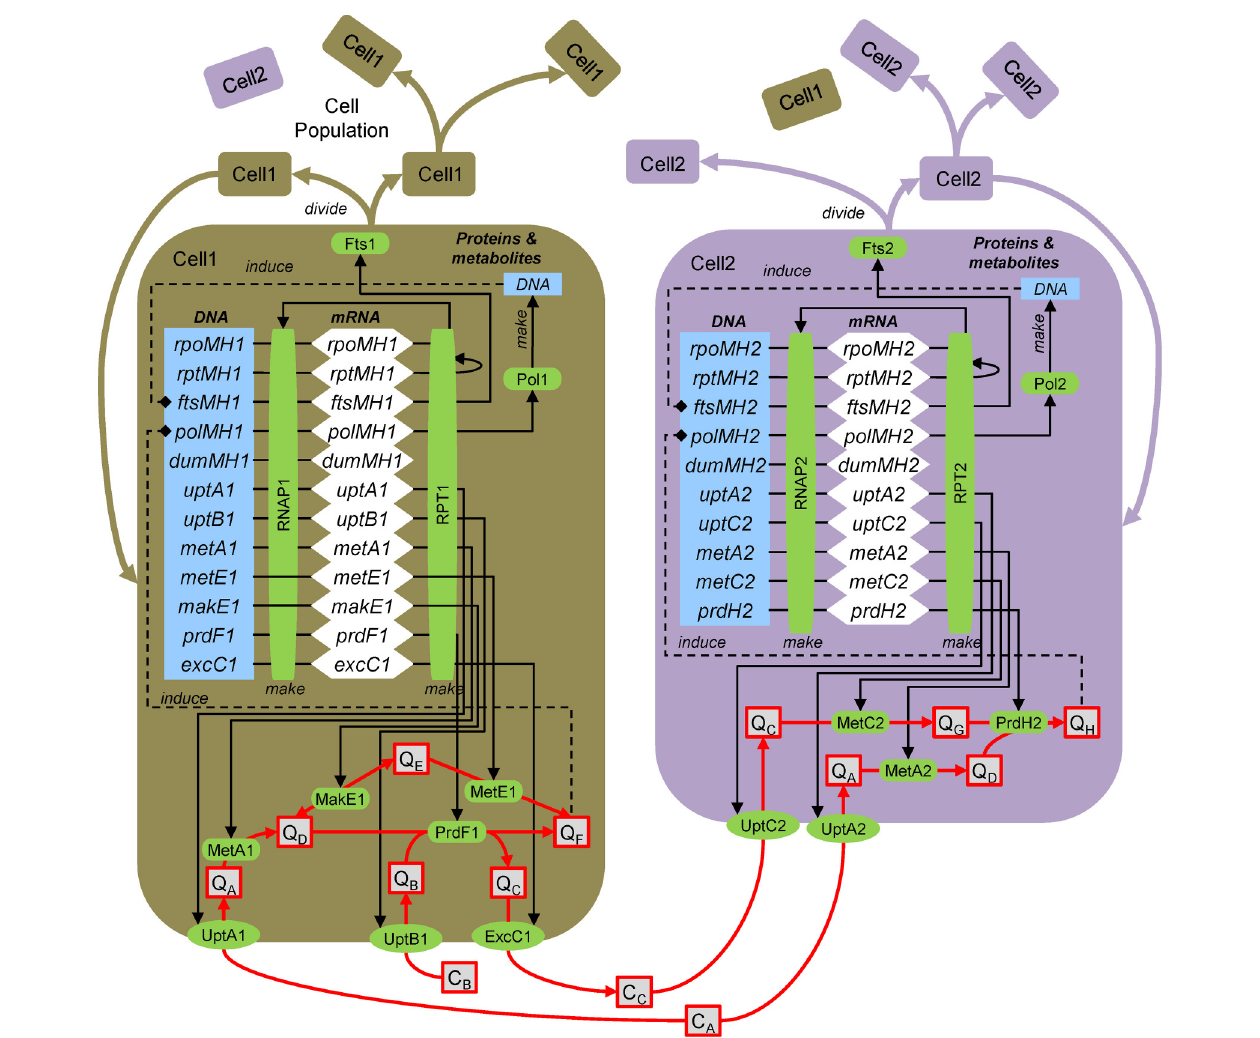
FIGURE B3 | Agent-based modeling of microbes. Gene/protein: rpoMH /RNAP, RNA polymerase; rptMH /RPT, ribosome; ftsMH /Fts, cell division; polMH /Pol, DNA polymerase; dumMH , dummy (accounts for genes not explicitly considered); uptA /UptA, uptake A; metA /MetA, metabolism A; excC /ExcC, excretion C. Substrates and metabolites (extracellular, concentration C; intracellular, quota Q): C A , substrate A; Q H , metabolite H, etc. After Figure 1 of Hellweger (2009). To illustrate the approach, we present the equations for uptB1 transcription, UptB1 synthesis, UptB1 rate and Q B mass balance. Here, intracellular concentrations are defined on a per biomass dry weight (DW) basis, but carbon and volume can also be used. The uptB1 transcript ( uptB1 t , mol mRNA gDW − 1 , i.e., per gram biomass dry weight) mass balance equation